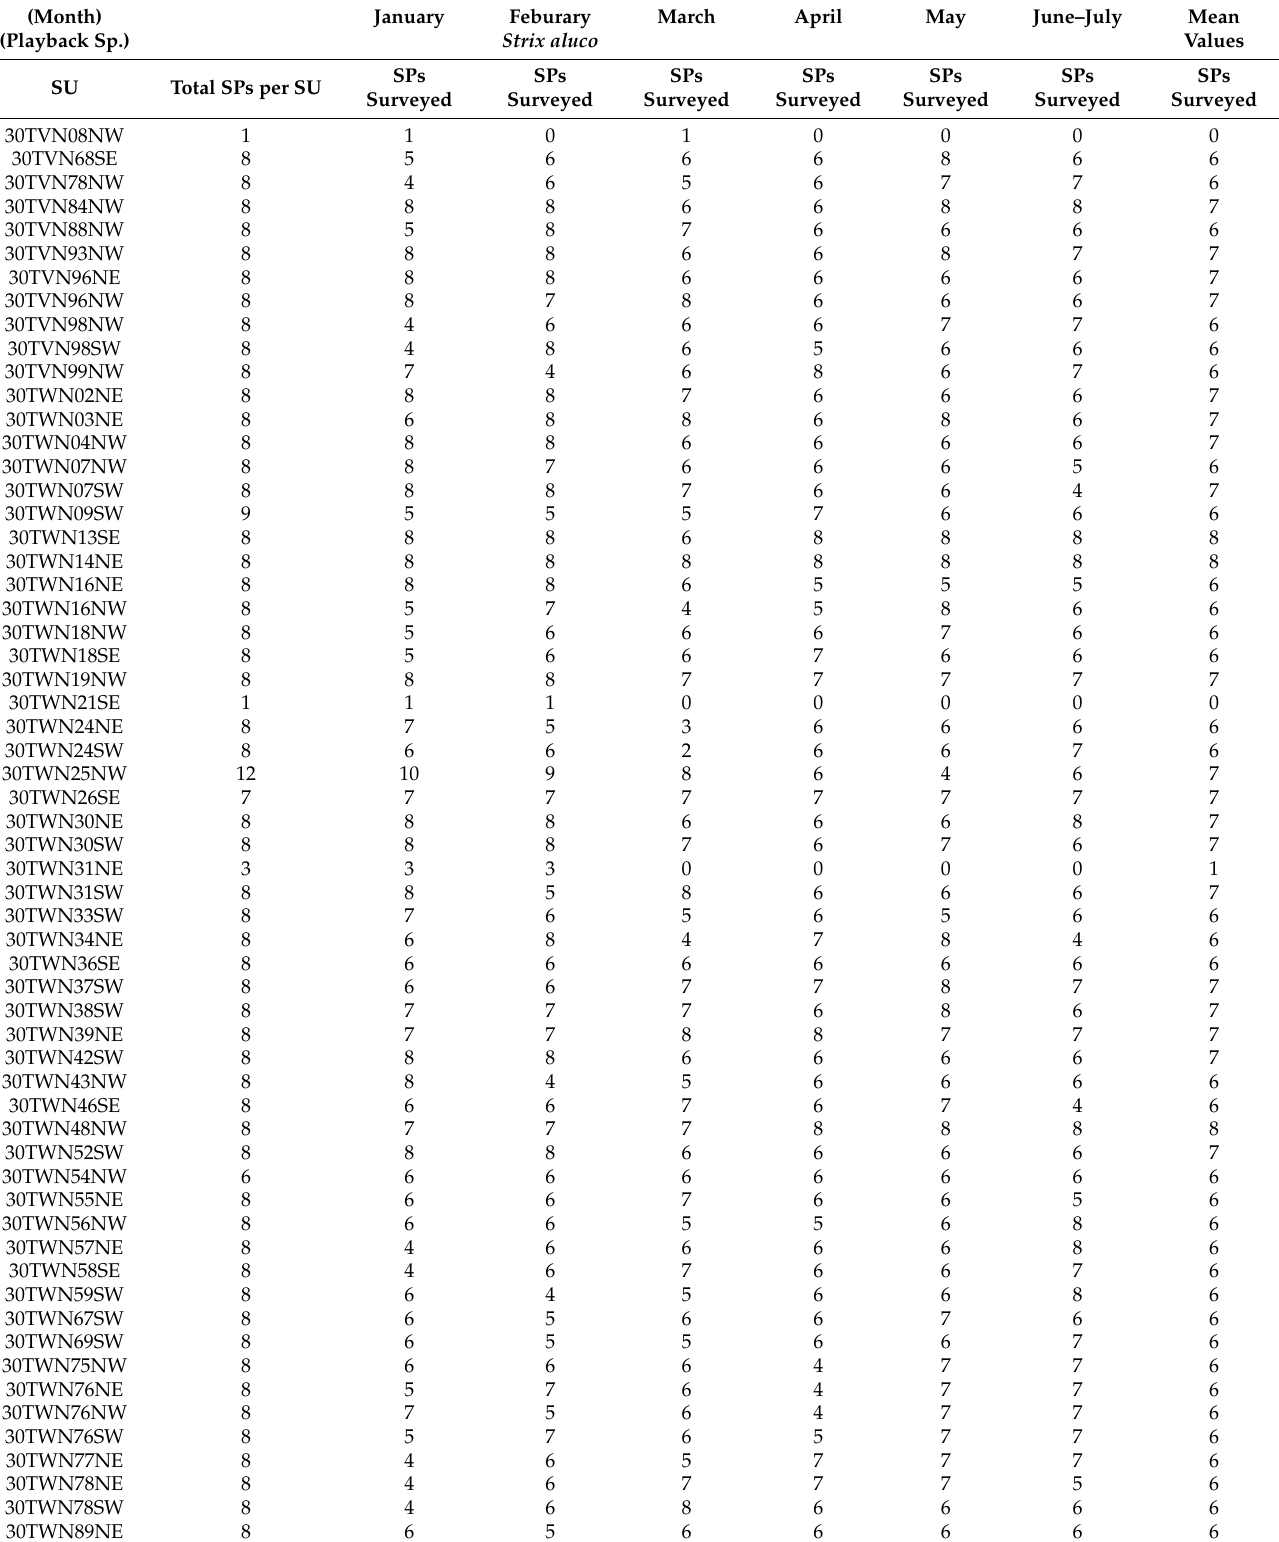
Table A1. A summary table of the number of survey points (SPs) in each survey unit (SU) each month. In total, 2507 SPs were